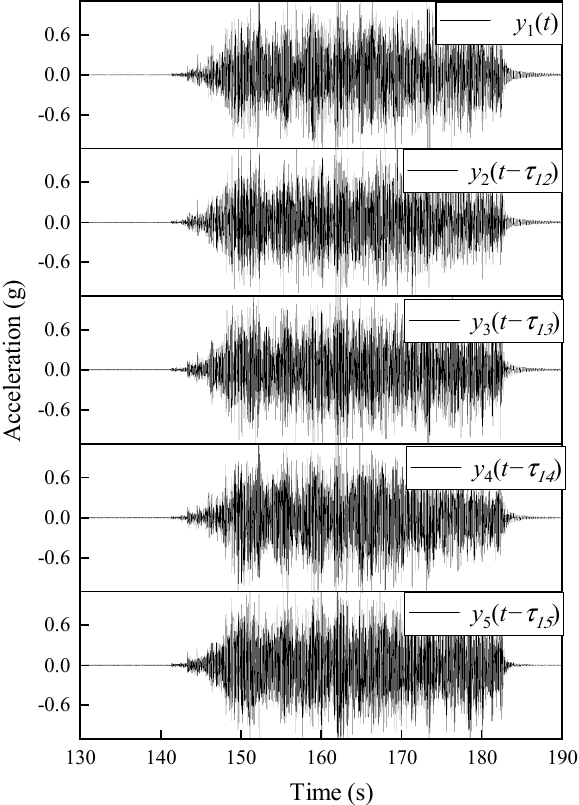
Figure 10. Artificially misaligned accelerations response under shake-table excitation.